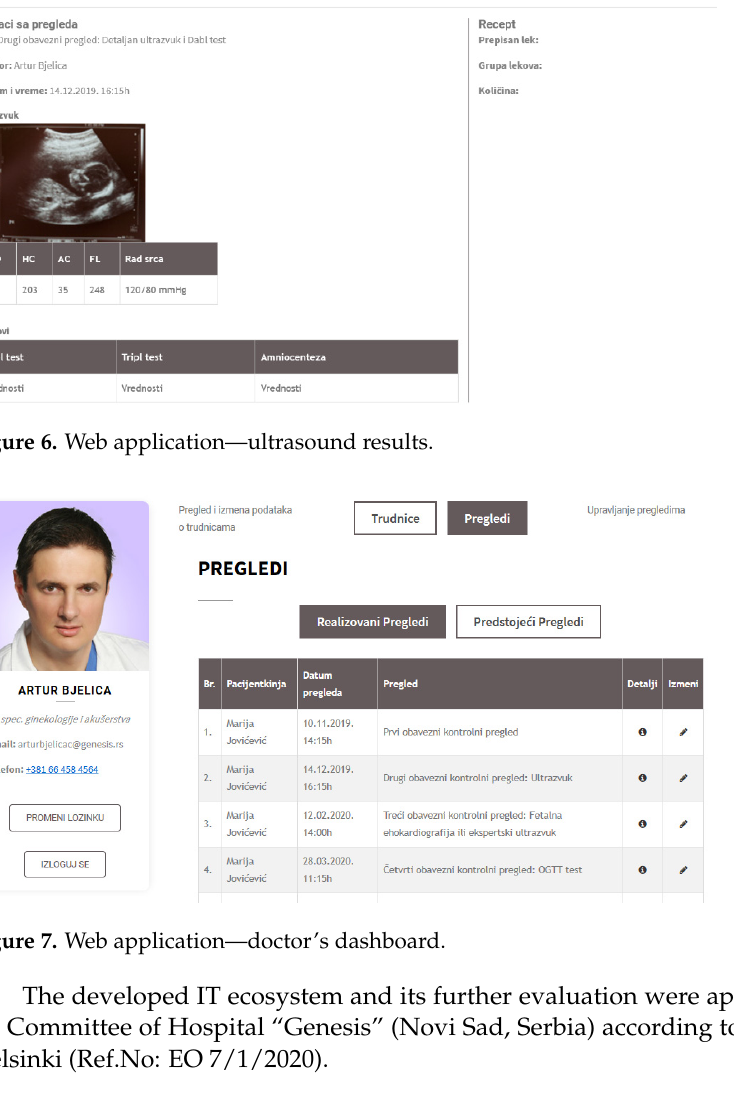
Figure 5. Web application — pregnant woman dashboard.